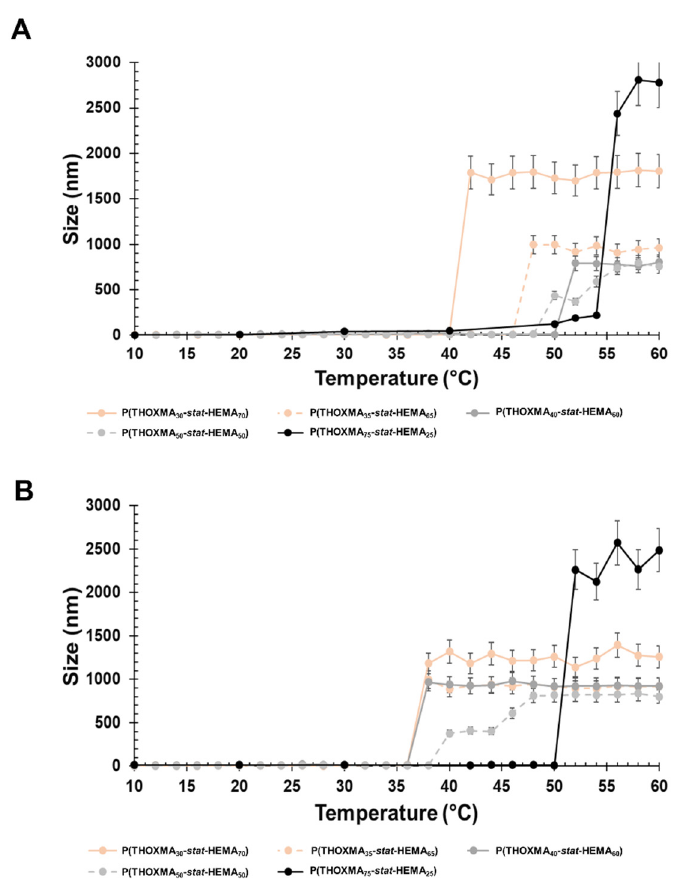
Figure 4. Particle size variation with the temperature of copolymer formulations (1 g/L) at physio- logical pH (pH 7.4) ( A ) and alkaline pH (pH 10) ( B ).